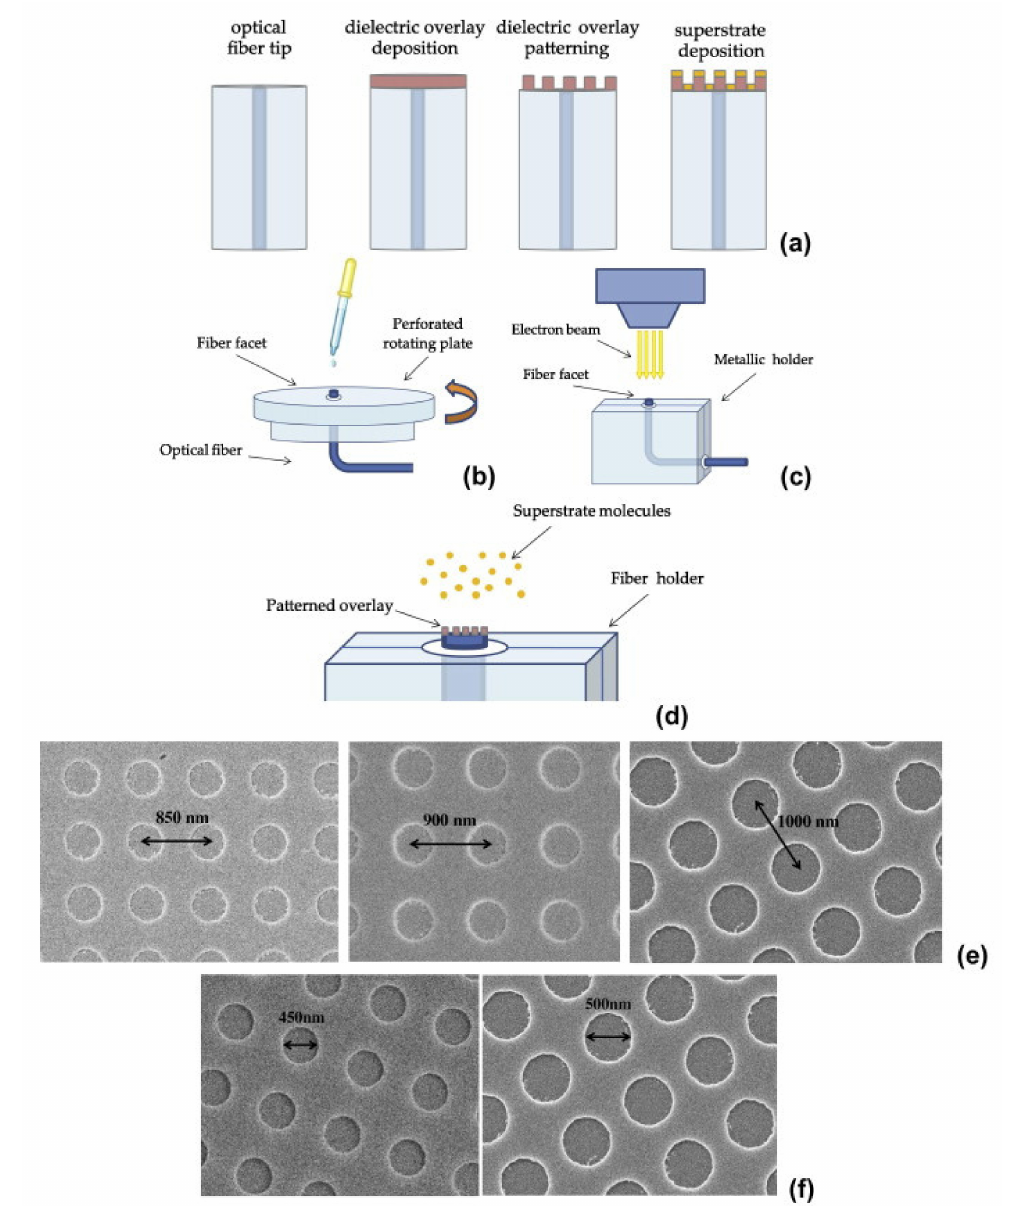
Figure 2. ( a ) Schematic of the ( a ) steps involved in the fabrication process, ( b ) customized chuck and holders for the spin coating, ( c ) overlay patterning, and ( d ) superstrate deposition. Metallo-dielectric crystals characterized by ( e ) different periods, and ( f ) holes diameters, directly realized on the fiber tip. Reprinted with permission from Ref. [10]. Copyright 2013